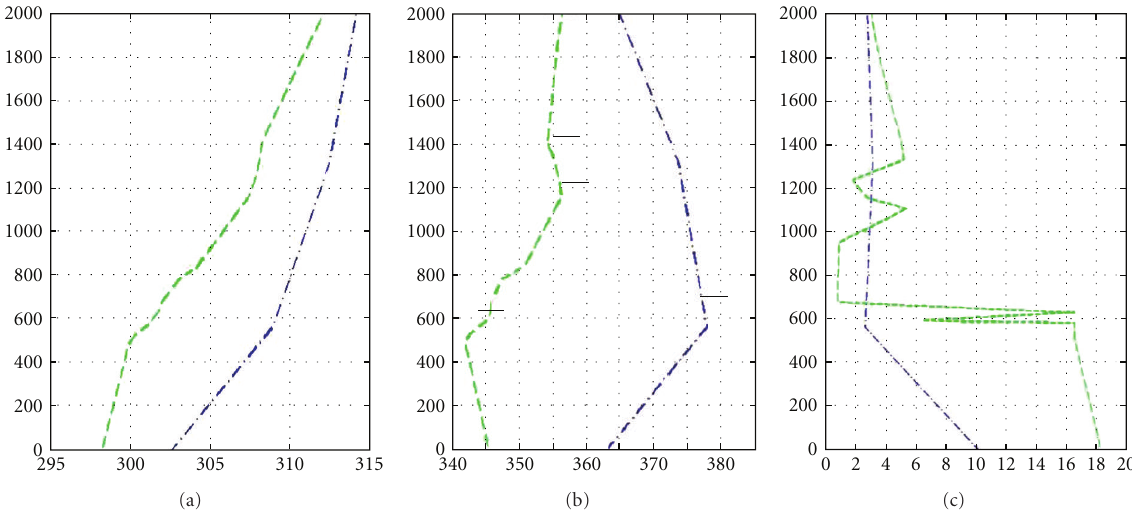
Figure 14: Potential temperature θ (a), equivalent potential temperature θ e (b), and mixing ratio r (c) profiles of 08/19/06 at 1200 UTC (blue) and 08/23/06 at 0000 UTC (green) in